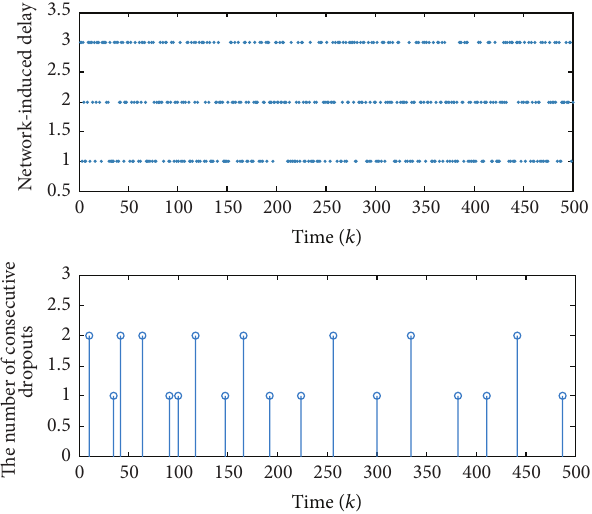
Figure 4: The system output signal and actually transmitted signal.